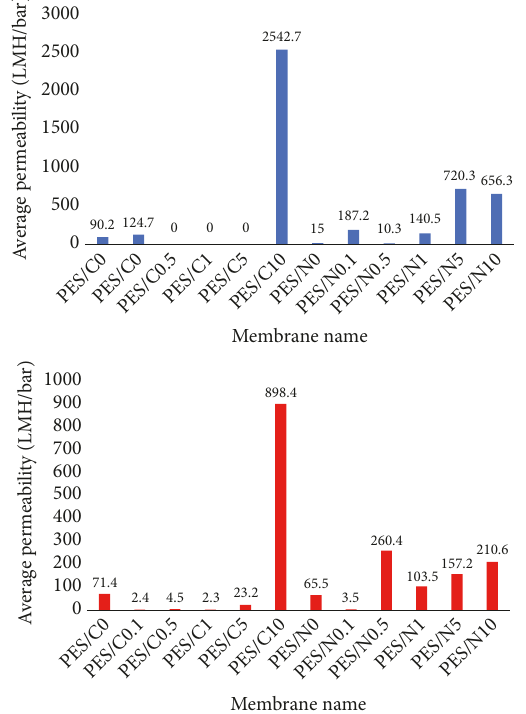
Figure 13: Pure water permeability of membranes cast from cold (in blue) and hot (in red) gel. porosity. However, PES/C10 showed the smallest capacity to retain water, which is entirely consistent with MICP and SEM